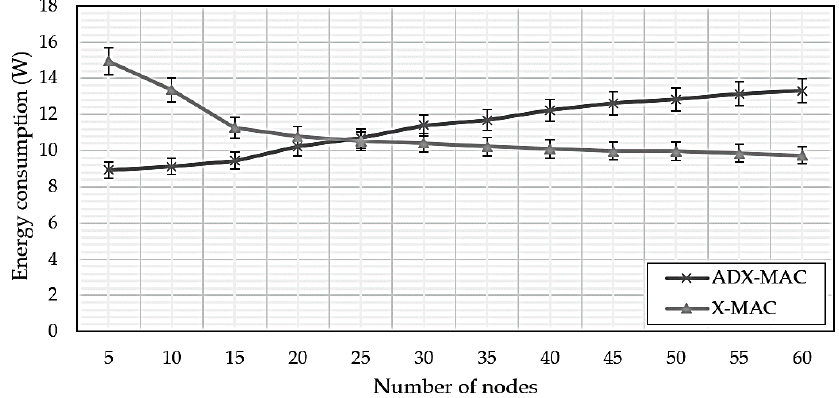
Figure 8. ADX-MAC and X-MAC energy consumption.